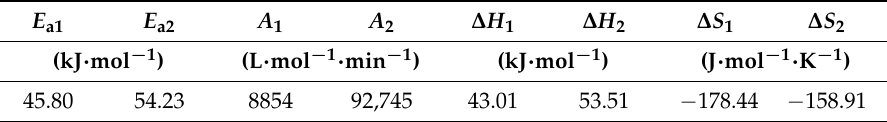
Table 2. Thermodynamic parameters for the reaction of HTPB-IPDI